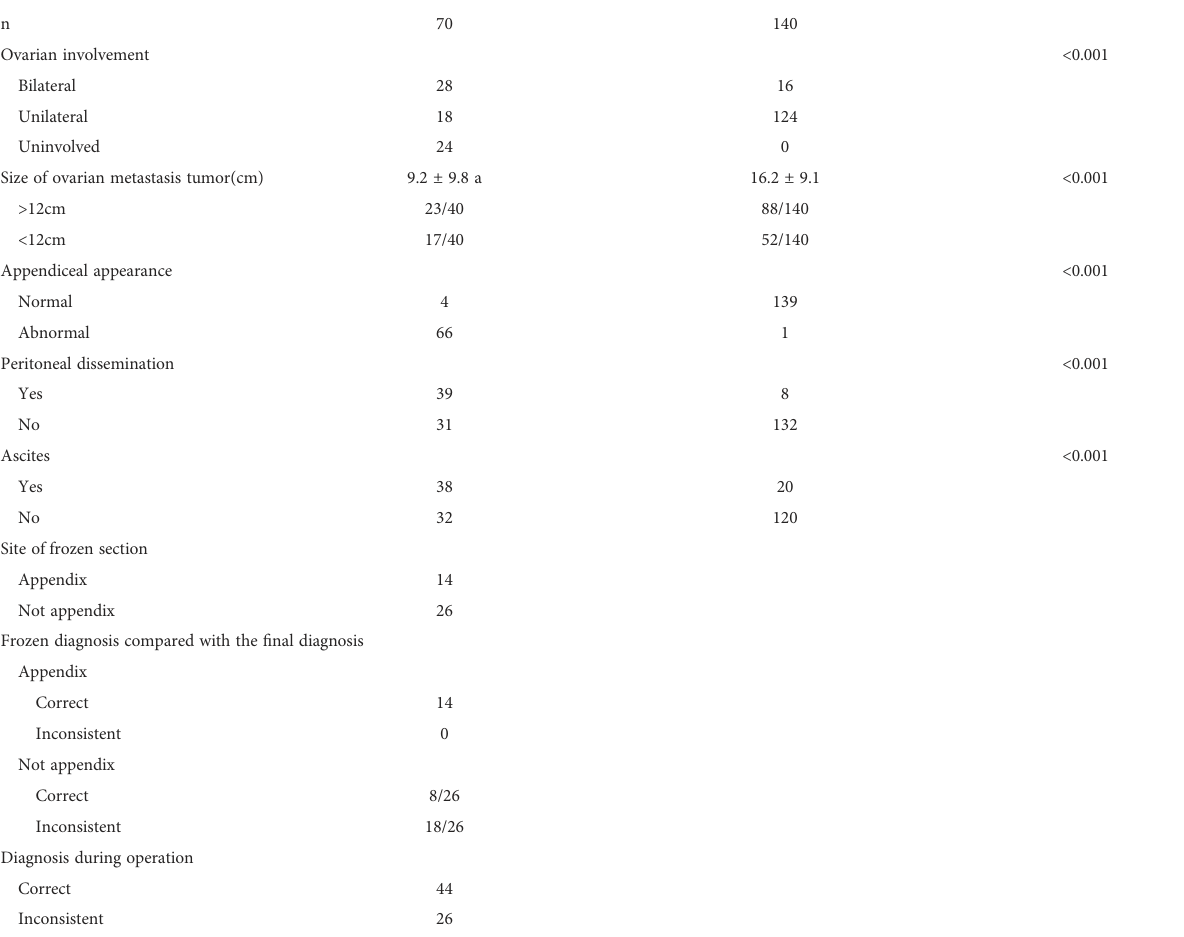
TABLE 2 Surgical fi